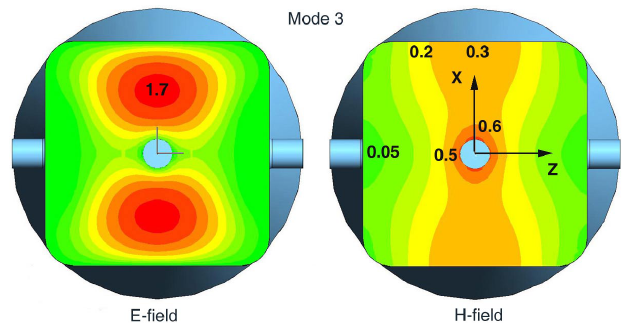
FIG. 10. (Color) Distribution of E -field, H -fields on the support plate of a displacement tuner. Numbers display ratios E=E H=H as a percentage, for a distance of the bar to the stub ends p of 20 mm. Red corresponds to high field, green to low